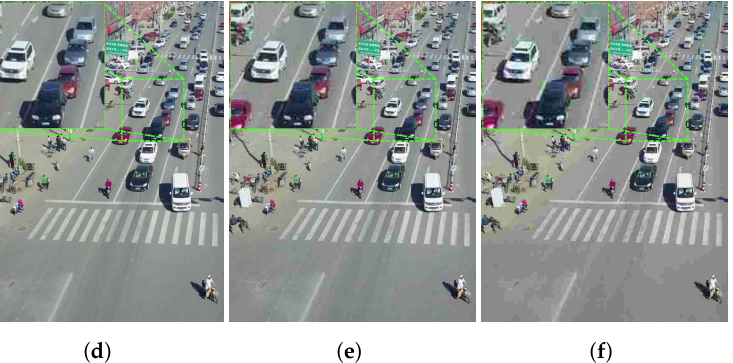
Figure A6. Example images for JPEG compression. ( a ) No comp.; ( b ) 90 comp. quality; ( c ) 70 comp. quality; ( d ) 50 comp. quality; ( e ) 20 comp. quality; ( f ) 10 comp. quality.